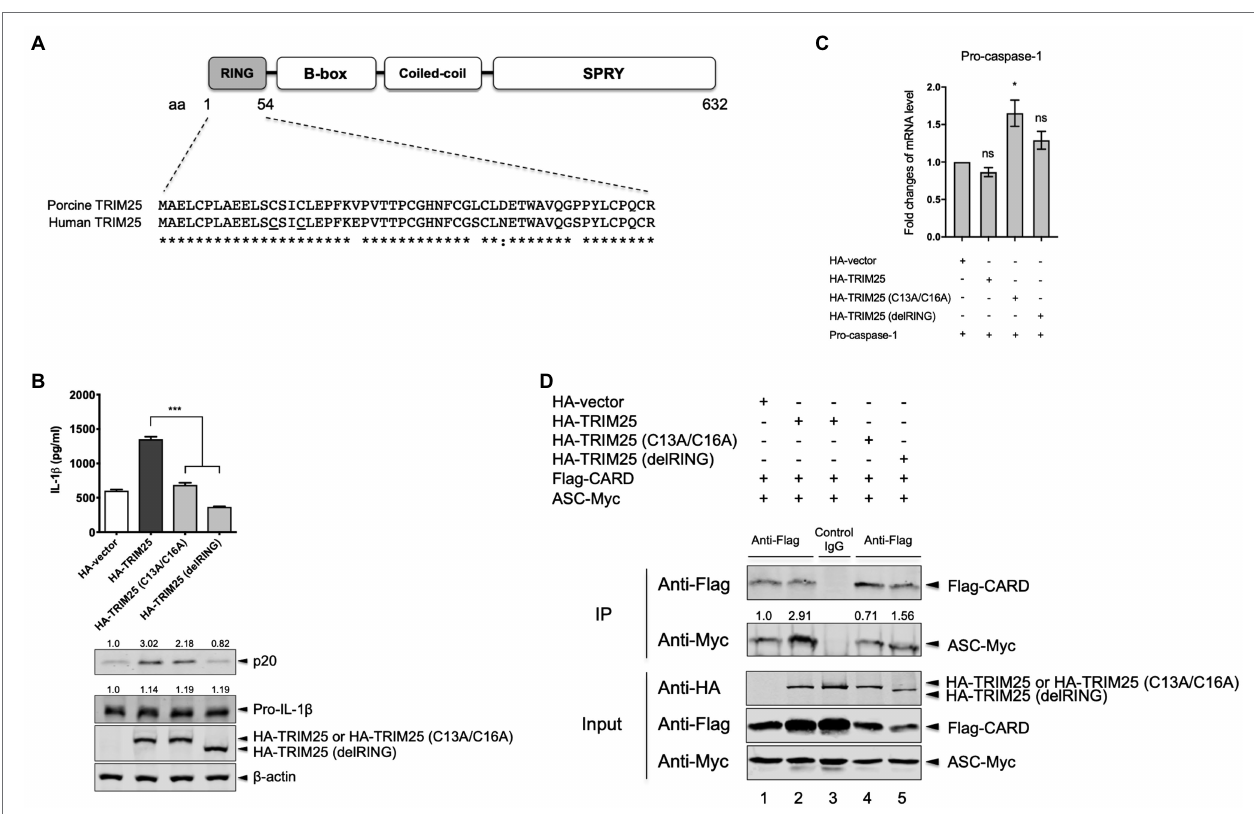
FIGURE 3 | TRIM25 RING domain is responsible for promoting the NLRP3 inflammasome activation. (A) Domain architecture of TRIM25 and amino acid sequence alignment of the RING domain between porcine and human TRIM25. The sequences are based on the GenBank accession numbers XM_005656971 for porcine TRIM25 and NM_005082 for human TRIM25. Amino acid positions are based on the sequence of porcine TRIM25. Residues (C13 and C16) known to be critical for the E3 ligase activity of human TRIM25 are underlined. Consensus symbols indicate as follows: asterisk (*), fully conserved residues; colon (:), residues that share strongly similar properties. (B) HEK293T cells were transfected with plasmids expressing porcine NLRP3 inflammasome components and pro-IL-1 β along with an empty HA-vector or a plasmid expressing HA-tagged porcine TRIM25 (WT or mutants) for 16 h. Porcine IL-1 β levels from cell-free supernatants were measured by ELISA. From cell lysates, the expression of proteins (p20, pro-IL-1 β , and HA-tagged TRIM25) was analyzed by Western blotting. Relative intensities of p20 and pro-IL-1 β to that in the samples with HA-vector were shown above each band. (C) HEK293T cells were transfected with plasmids as indicated for 18 h. Pro-caspase-1 mRNA levels were measured by quantitative PCR and expressed as fold changes over the expression level in cells transfected with pro-caspase-1 construct and an empty HA-vector. (D) HEK293T cells were transfected with plasmids expressing Flag-tagged porcine pro-caspase-1 CARD and Myc-tagged porcine ASC along with either an empty HA-vector or plasmids expressing TRIM25 (WT or mutants) for 24 h. Cell lysates were subjected to IP with mouse IgG isotype control or anti-Flag antibody. The expression of Flag-tagged CARD, Myc-tagged ASC, and HA-tagged TRIM25 (WT or mutants) in IP and input samples was analyzed by Western blotting using antibodies indicated. Relative intensities of ASC-Myc to that in lane 1 were shown above each band. Statistical analysis was performed with one-way ANOVA. ns, not significant; * p < 0.05; *** p < 0.001. Results are representative of three independent